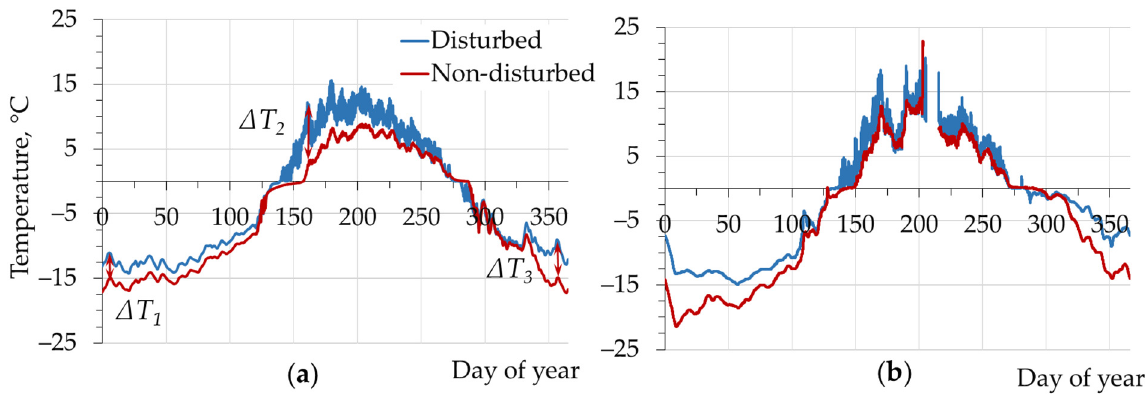
Figure 6. Annual temperature dynamics at a depth of 0.1 m: ( a ) simulation results for the basic variant of model parameters set (see Table 5) and ( b ) data of field observations in the research area (summarized experimental data from the work in [50]).